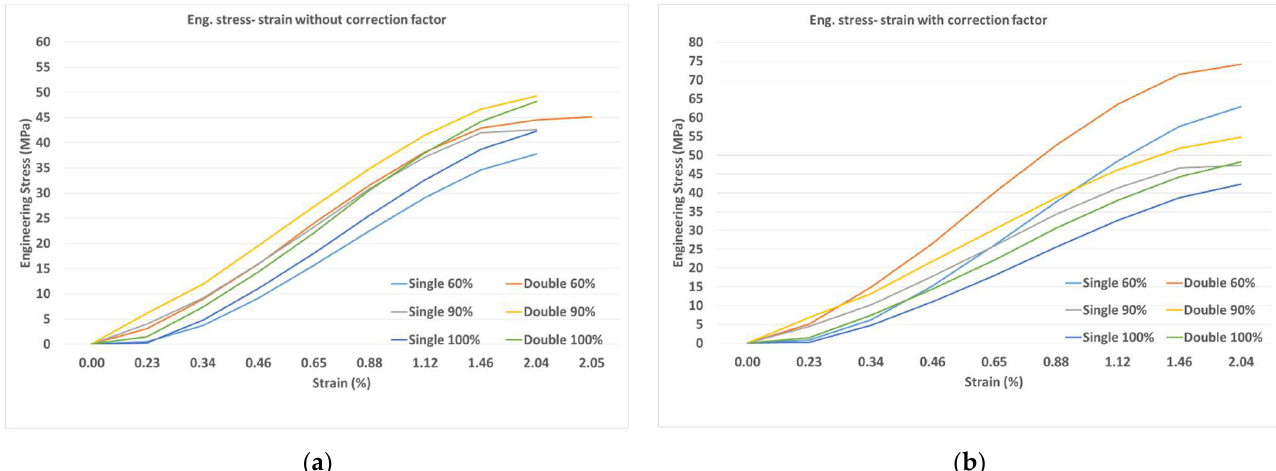
Figure 5. Engineering stress–strain: ( a ) without correction factor; ( b ) with correction factor of 0.6 for PRTS 60% infill, 0.9 for PRTS 90% infill, and 1.0 for PRTS 100% infill.